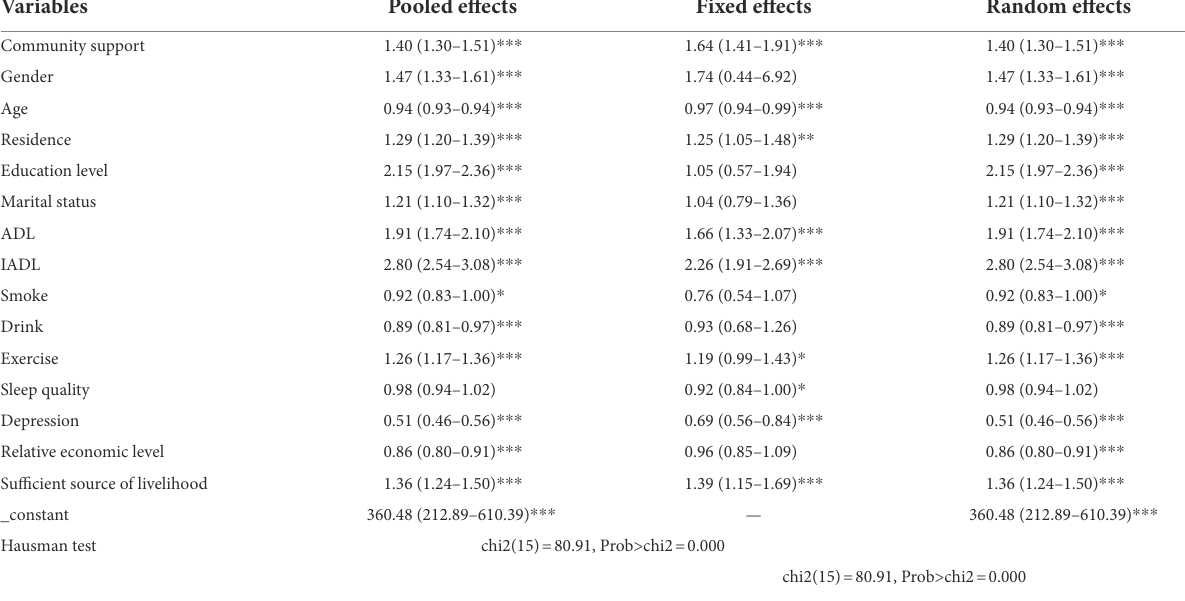
TABLE 2 Panel estimation results of the impact of community support on the cognitive function of the elderly, OR (95% CI).